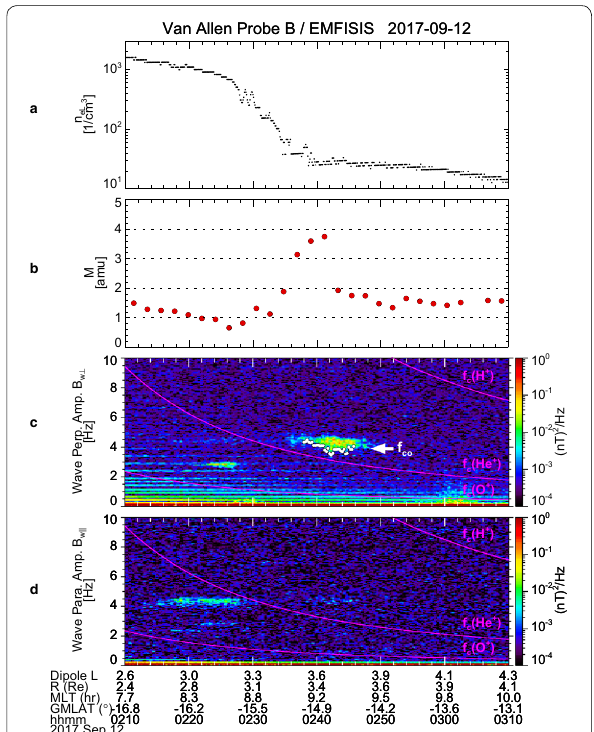
Fig. 6 Van Allen Probe B/EMFISIS observations of a electron density at the satellite position, b average plasma mass, and c , d the dynamic power spectra of wave amplitudes in the directions perpendicular/ parallel to the local magnetic field, during 02:10–03:10 UT on 12 September 2017. Data are the same as d , e , 5 a , and b . White dots indicate the lower cutoff frequency ( f co ) of the emission of an electromagnetic ion cyclotron